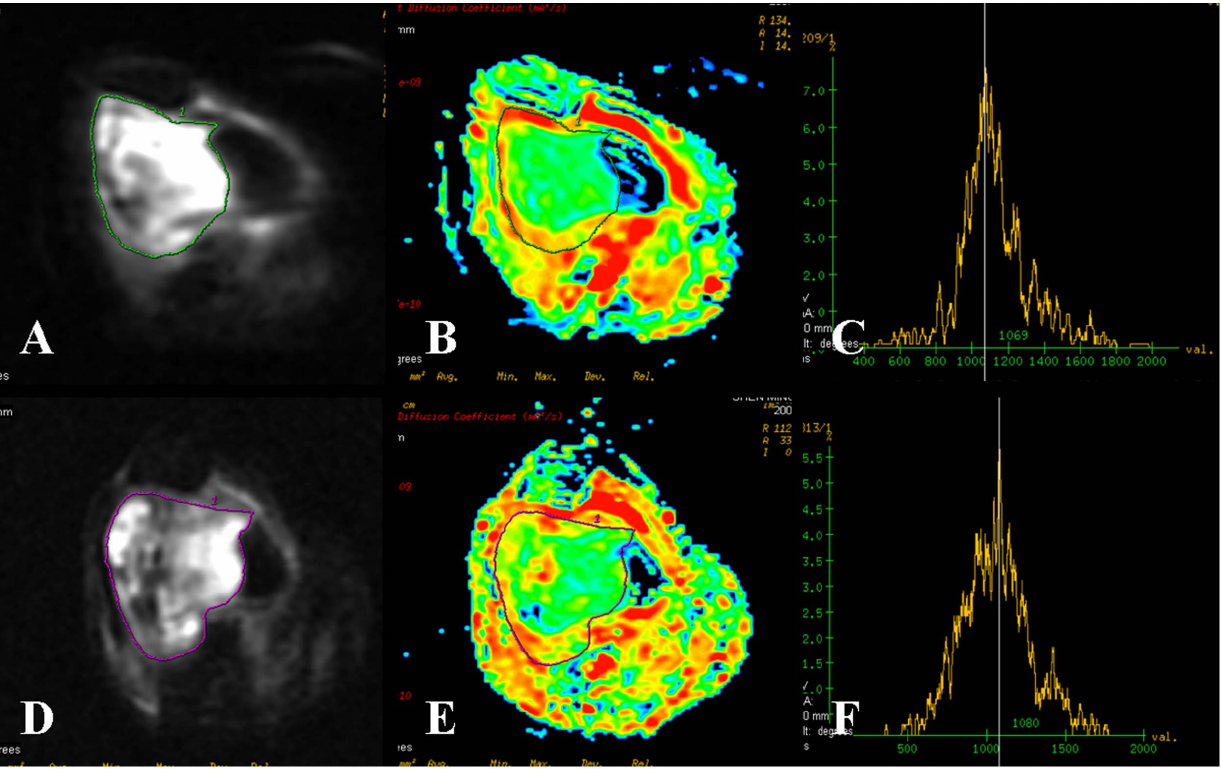
Figure 3. Osteosarcoma of the distal femur in a 46-year-old woman with poor response. ( A , C ) DWI map, ADC map and ADC histogram before neoadjuvant chemotherapy. The tumor on DWI map was mixed high signal intensity. The ADC value of the whole tumor was 1.35 6 10 2 3 mm 2 / s with a subtotal green area. The ADC histogram was high and sharp. ( D , F ) DWI map, ADC map and ADC histogram after neoadjuvant chemotherapy. The tumor on DWI map was mixed signal intensity. The ADC value of the whole tumor (1.31 6 10 2 3 mm 2 /s) and the ADC histogram were similar to those of pre- neoadjuvant chemotherapy. Tumor necrosis rate of 20% was confirmed by postoperative pathological evaluation. The effectiveness of neoadjuvant chemotherapy was